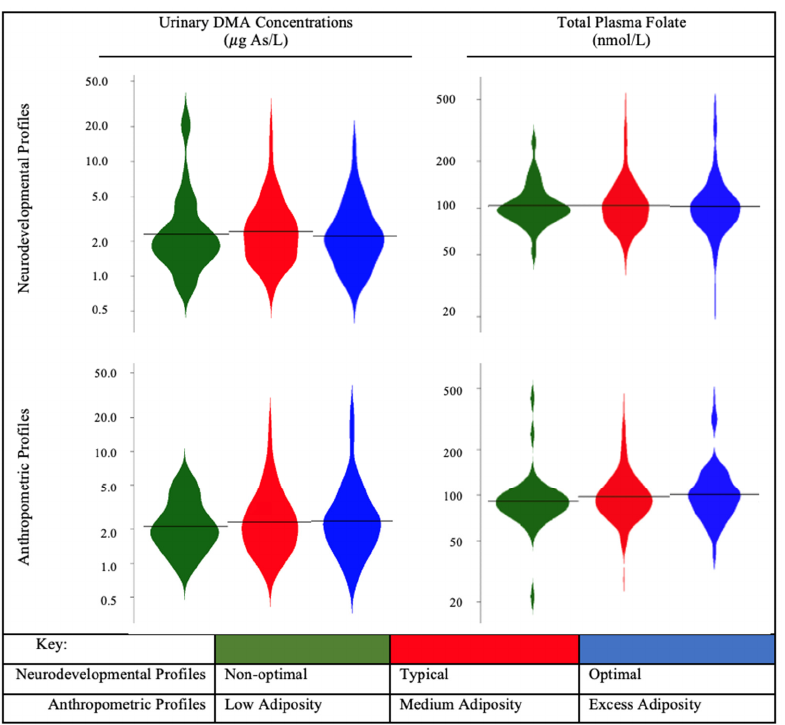
Figure 1. Violin plots of first trimester maternal urinary concentrations of DMA and total plasma folate during pregnancy by neurodevelopmental and anthropometric phenotypic profiles among MIREC study participants; MIREC: Maternal–Infant Research on Environmental Chemicals; DMA: dimethylarsinic acid; total folate: sum of five folate vitamers, 5-methylTHF, folic acid, tetrahydro- folate (THF), 5-formylTHF, and 5,10-methenylTHF. Horizontal bar represents median value of first trimester urinary DMA concentrations or plasma total folate. For descriptive information of pheno-